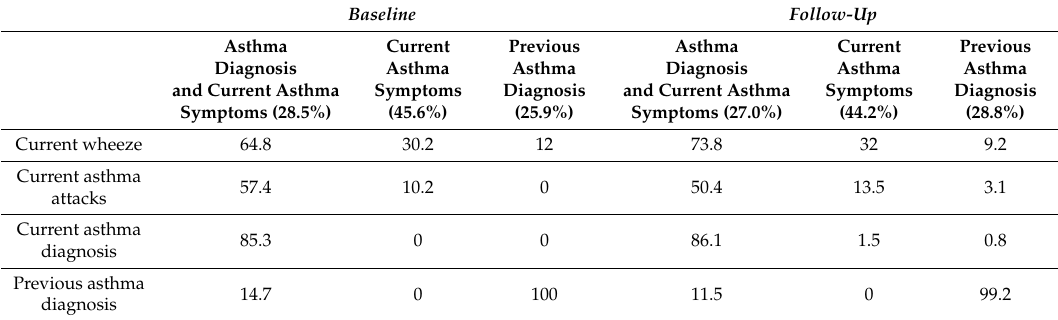
Table 3. Asthma symptoms/diagnosis frequency (%) within each cross-sectional phenotype.